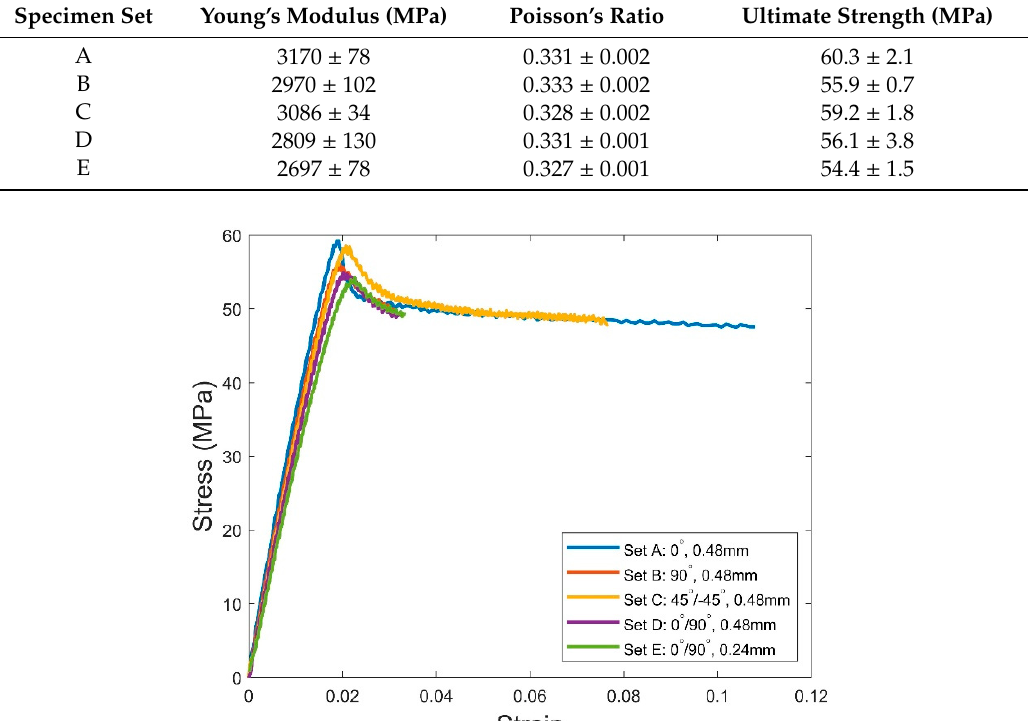
Table 7. Mechanical properties for the 3D printed PLA material.